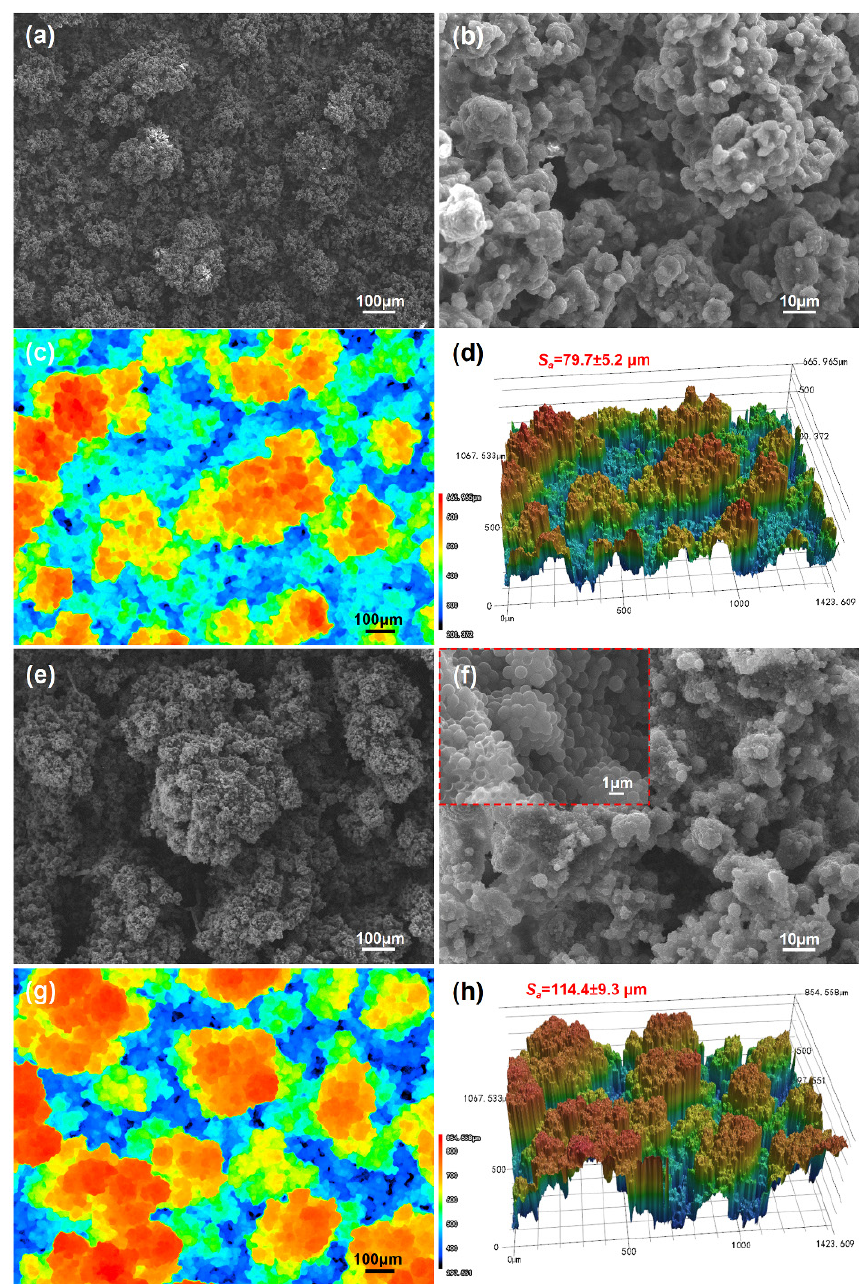
Figure 5. ( a , b ) SEM images and ( c , d ) CLSM images of the surface of SS; ( e , f ) SEM images and ( g , h ) CLSM images of the surface of SNC.